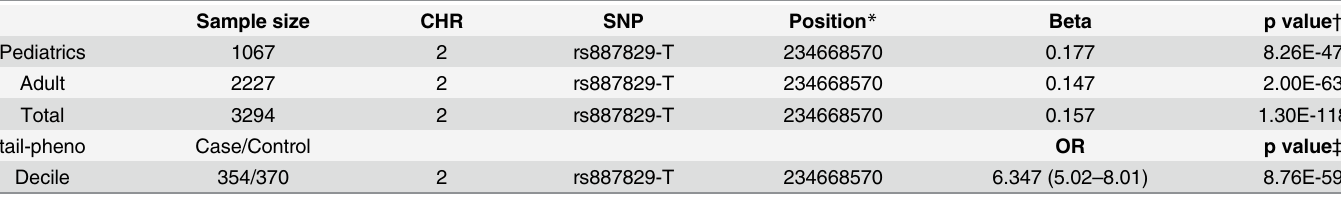
Table 2. Quantitative and case-control association result of top SNPs in UGT1A1 for total serum bilirubin levels in pediatric and adult subgroups. Sample